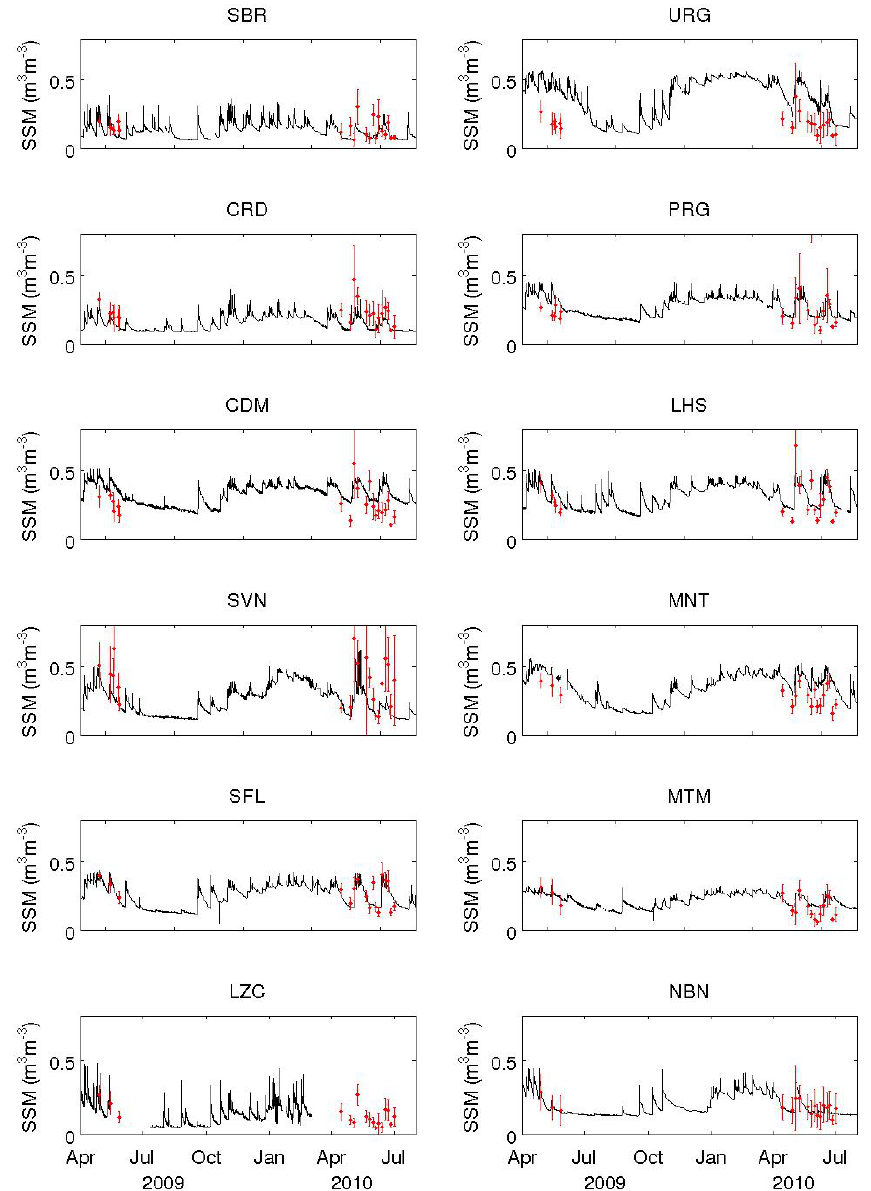
Fig. 4. Temporal variability of the SSM measured by the SMOSMANIA stations (black line) and of the CAROLS SSM (red dots with std error bars): SBR – Sabres, URG – Urgons, CRD – Cr´eon d’Armagnac, PRG – Peyrusse-Grande, CDM – Condom, LHS – Lahas, SVN – Savenes, MNT – Montaut, SFL – Saint-F´elix de Lauragais, MTM – Mouthoumet, LZC – L´ezignan-Corbi`eres, NBN –